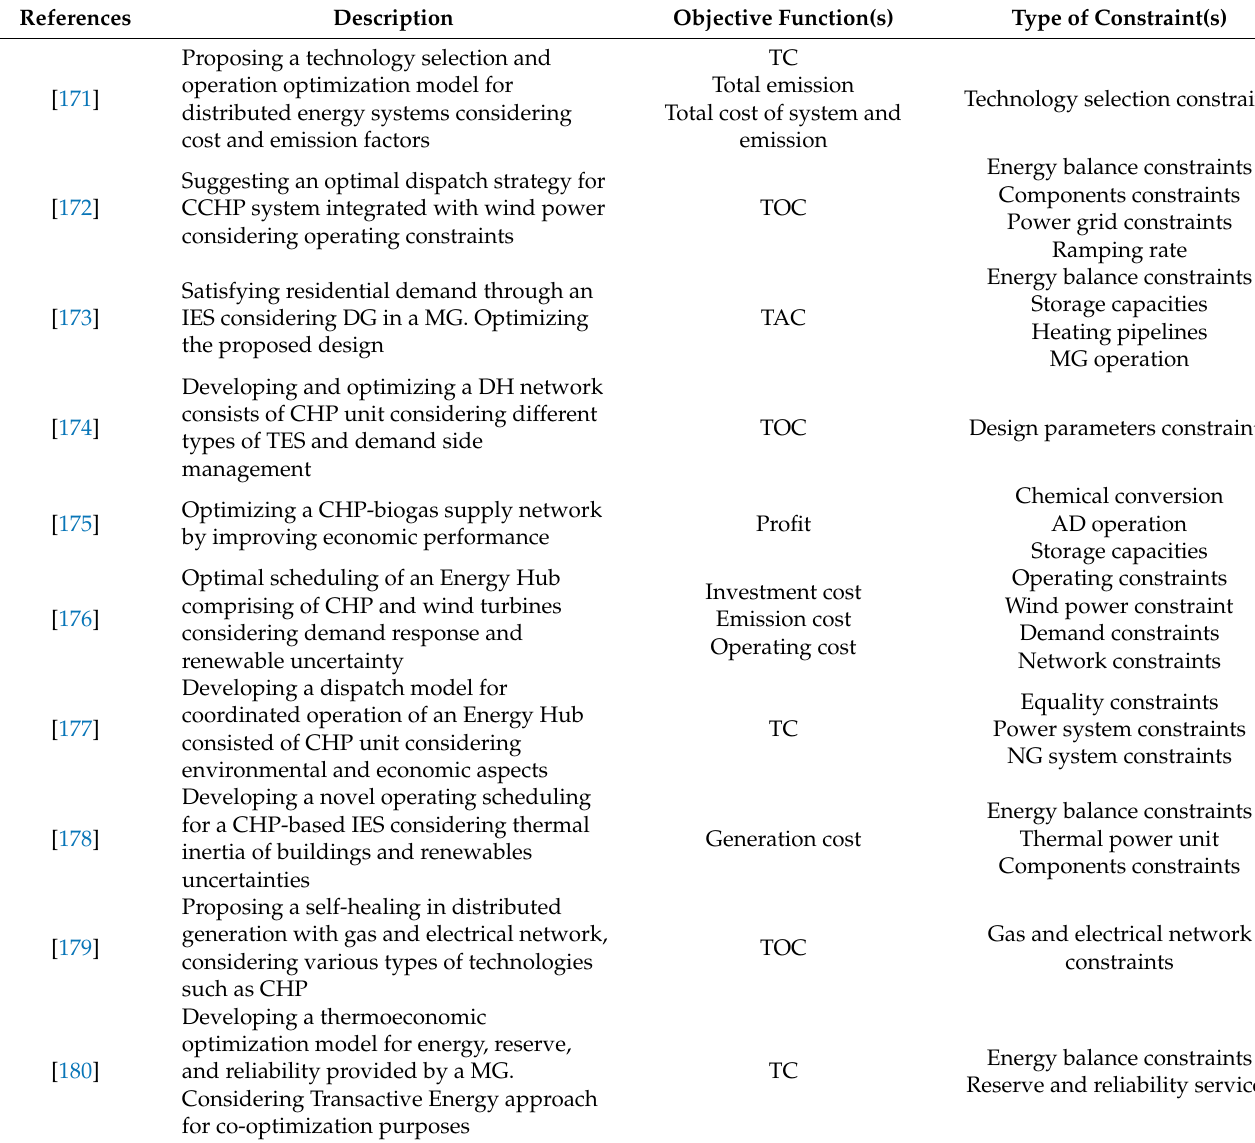
Table 4. Selected preliminary studies on energy system optimization using the MILP